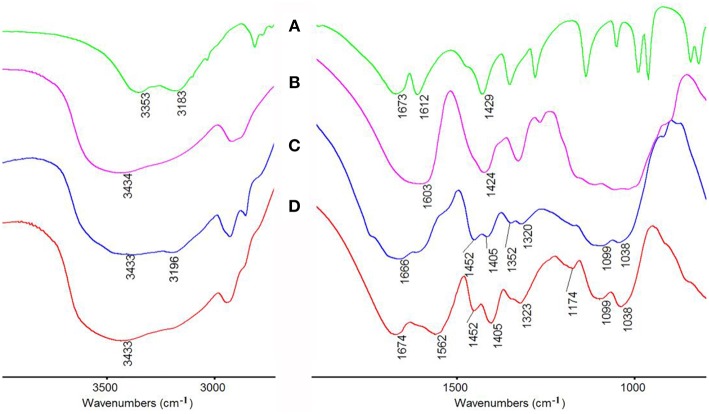
FTIR spectra of (A) AM, (B) CMC, CMC-g-PAM/MMT (C) before and (D) after hydrolysis reaction.